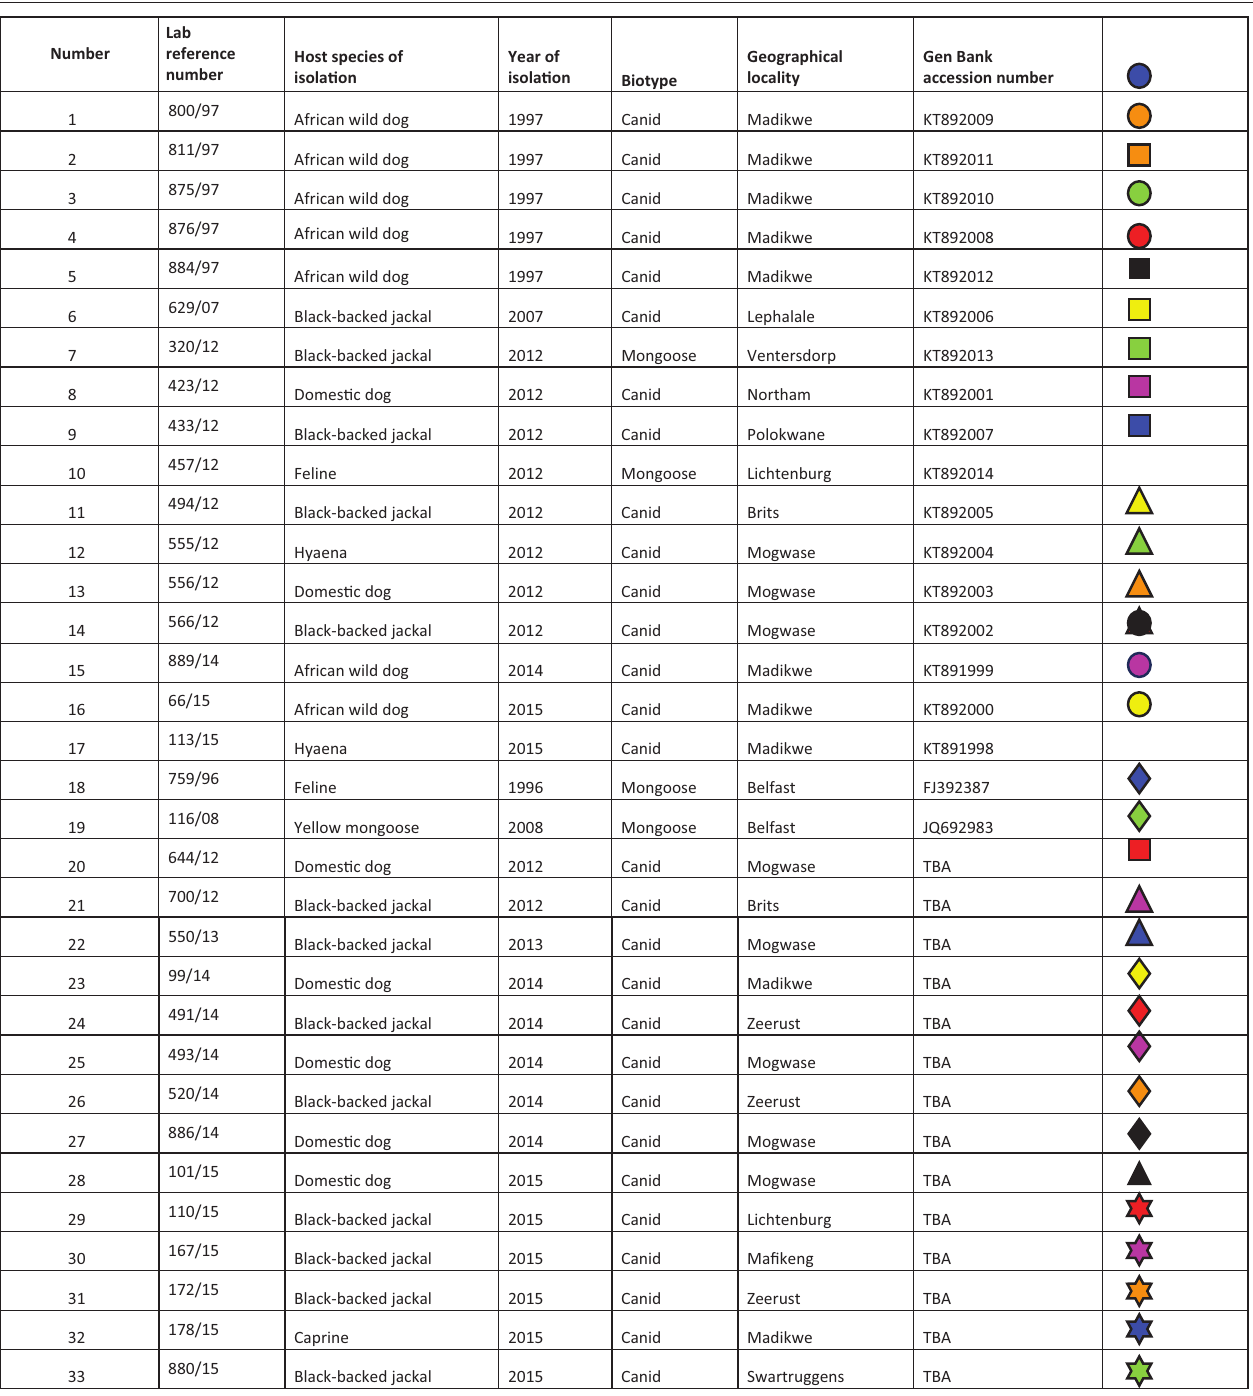
FIGURE 2: Rabies virus isolates used in the study including wild and domestic animal isolates isolated over a 19-year